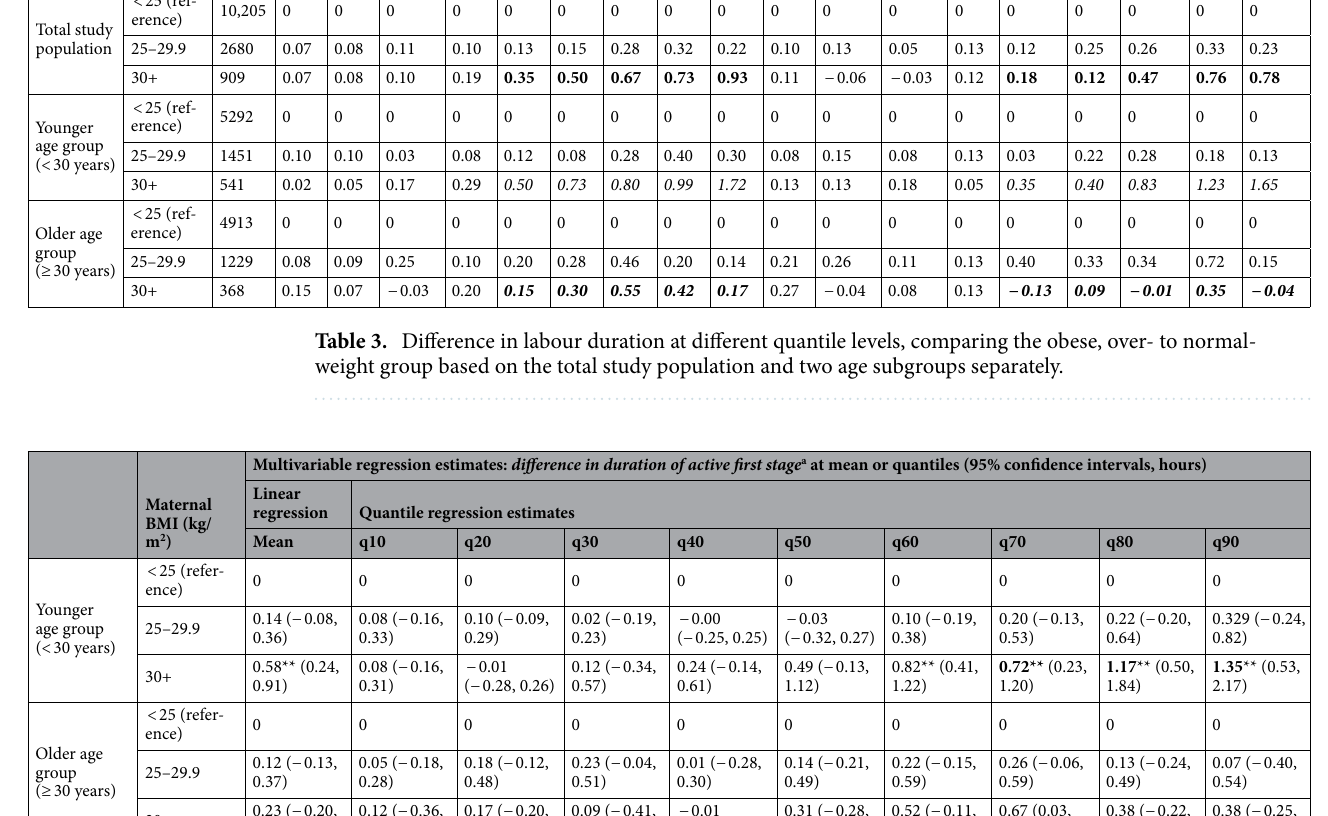
age strata. Compared to normal weight women, obese women were more likely to receive oxytocin for labour augmentation and to deliver via caesarean. In addition, caesarean delivery was more common among older obese women (older 17.7% vs. younger 12.0%). The duration of second stage of labour was longer among older women regardless of BMI category, see Table 1. Table 2 show the distribution of duration of active first stage across the three BMI categories in the study population overall and stratified by age. When comparing all women in the cohort, duration of the active first stage increased with higher BMI. The outcome distribution by quantile levels is presented in Table 3, with normal BMI as reference. Difference in distribution of duration in the total study population in the 90th quantile was 0.93 h. The corresponding differ- ence in distribution of duration, 90th quantile, within the age stratified groups was 1.72 in the younger age group and 0.17 h in the older age group, Table 3. The median duration was 0.50 h longer for obese women compared to normal weight women in younger age group (6.17 h vs. 5.67 h, respectively), Table 2 and 3. Results from the Kolmogorov–Smirnov test revealed a statistically significant difference (p-value = 0.002), comparing obese to normal-weight, in the younger age stratum, for the primary outcome (see Supplementary Fig. S2). While similar patterns were noted among older women, differences were much less pronounced, Table 3. For the secondary outcome, total duration of labour (including both first stage active and second stage), older women with obesity had faster labours at several quantiles compared to older women with lower BMIs, Table 3. No significant differ- ences were found from the Kolmogorov–Smirnov test among the older age stratum (see Supplementary Fig. S2). Multivariable regression estimates for the total study population for both primary and secondary outcomes were shown in Supplementary Tables S1 and S2, with univariate regression estimates presented in Supplementary